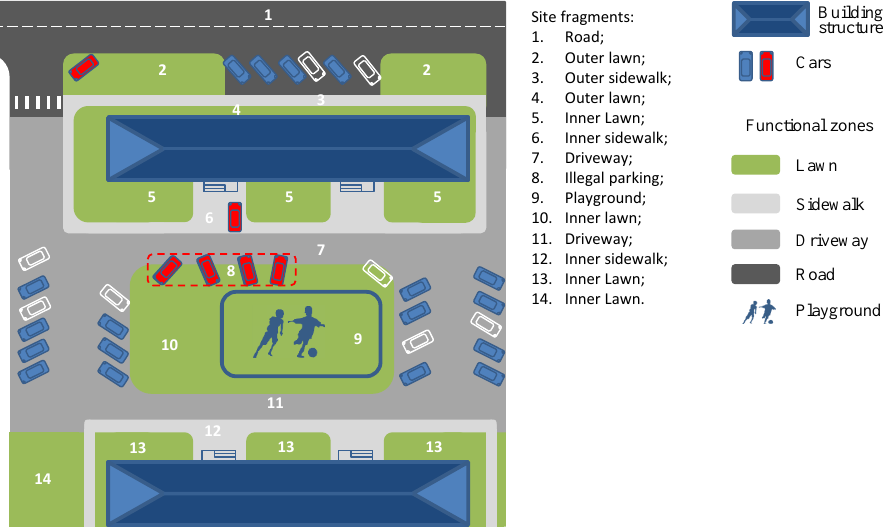
Figure 3. Schematic division of an elementary urban residential landscape (EURL) into segments and functional zones.